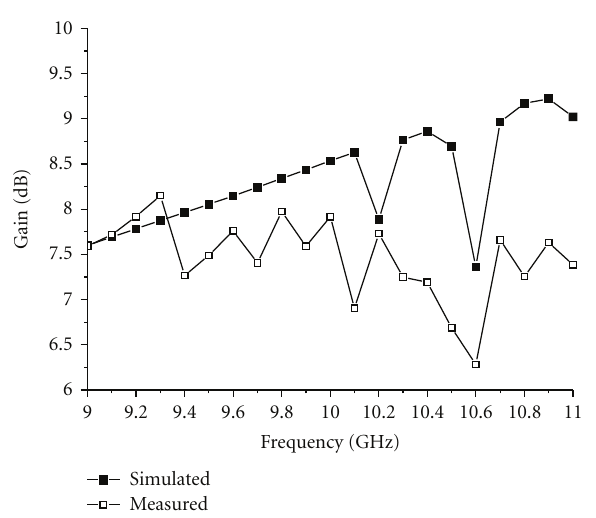
Figure 5: Simulated and measured gains at θ = ϕ = 0 ◦